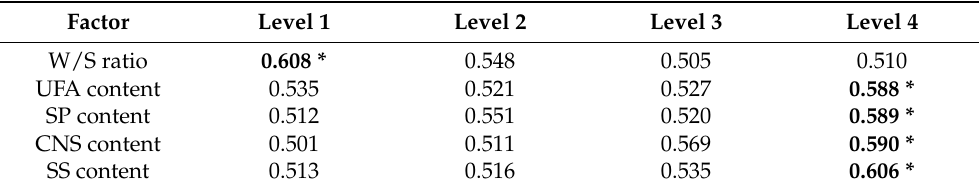
Table 11. Average GRG values for each level of all the